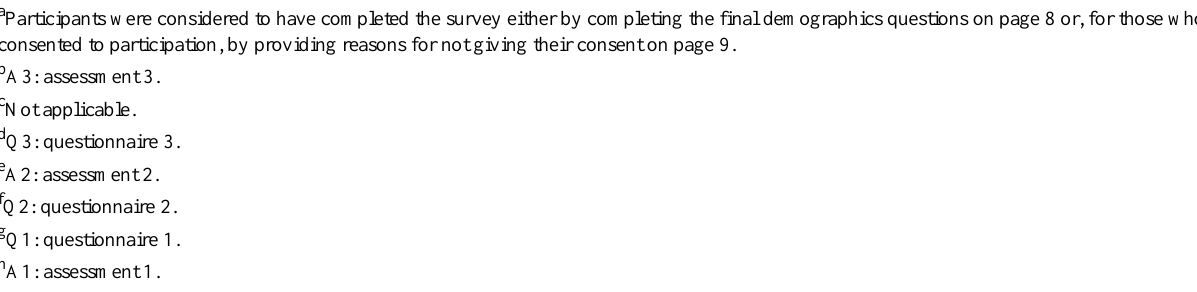
Dropouts, nFull completion of survey a , nDescriptionSurvey page